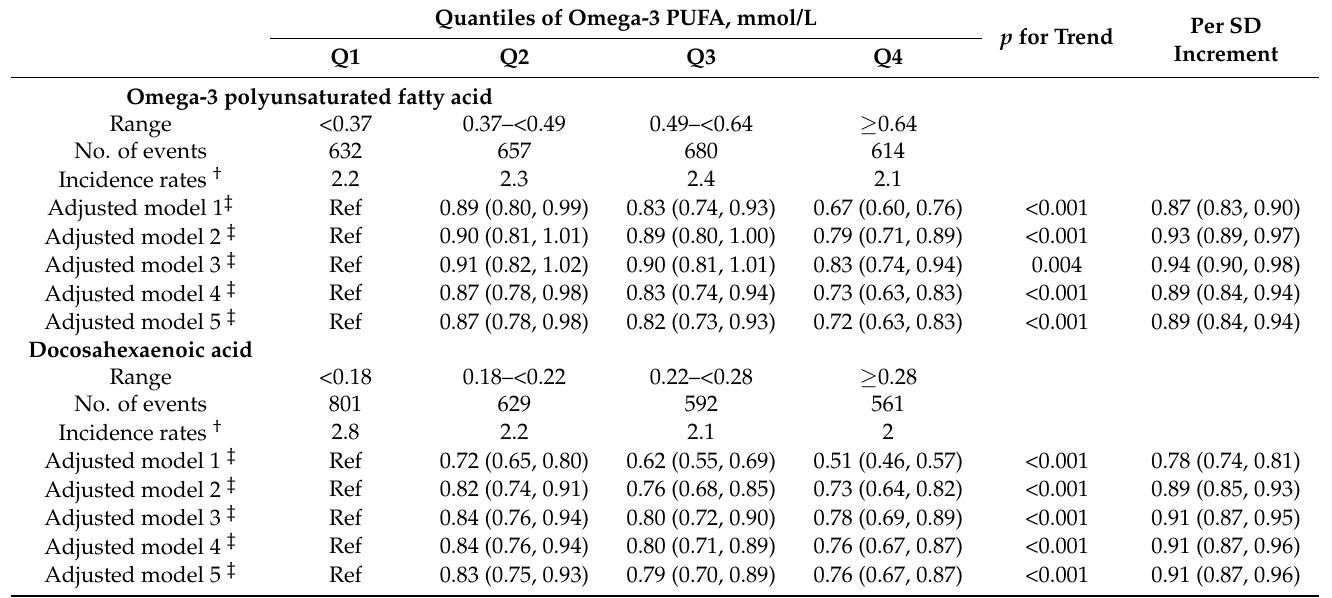
Table 3. The relationship between circulating Omega-3 polyunsaturated fatty acid with risk of incident chronic kidney disease